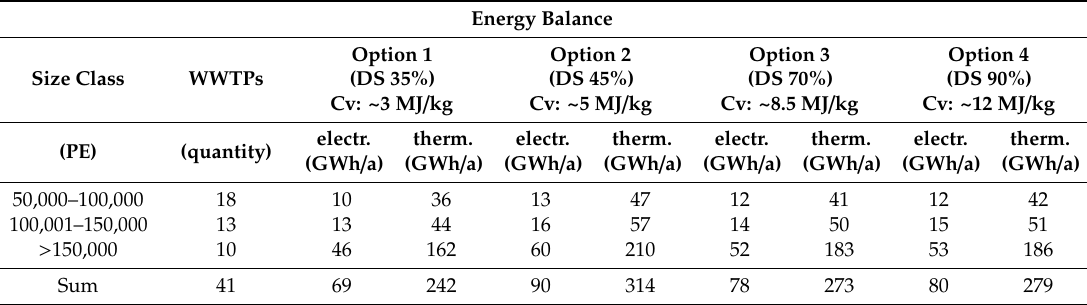
Table 8. Results of the energy balance of 41 WWTPs divided by size class and pre-treatment options 1–4. Energy potentials are given in electrical energy (electr.) and thermal (therm.) energy. The calorific value (Cv) is displayed for each treatment option